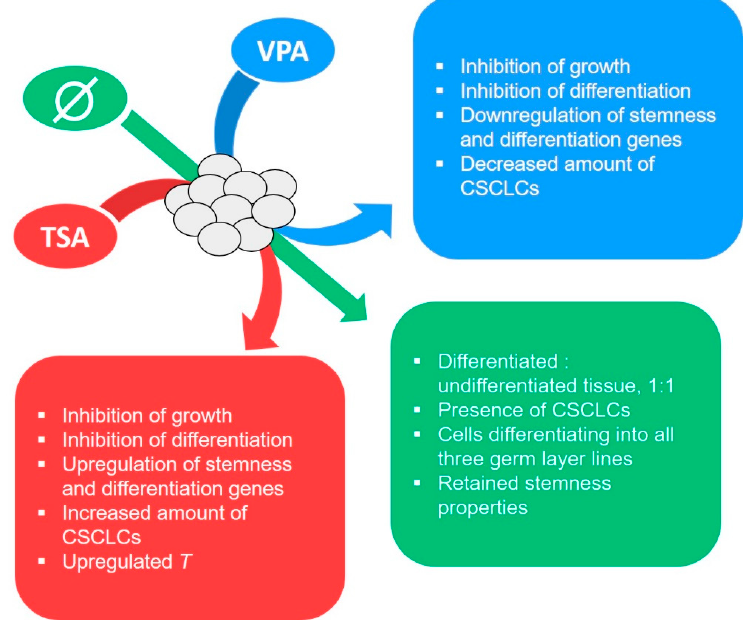
Figure 11. Graphical depiction of key conclusions.